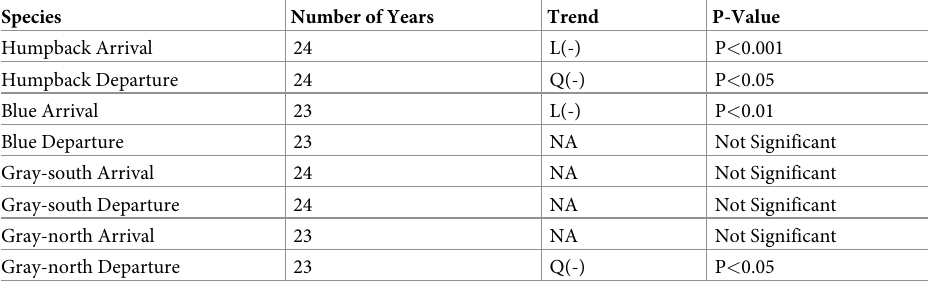
Table 2. Changes in timing for humpback, blue, and gray whale arrival and departure times. Species Number of Years Trend P-Value Humpback Arrival 24 L(-) P < 0.001 Humpback Departure 24 Q(-) P < 0.05 Blue Arrival 23 L(-) P < 0.01 Blue Departure 23 NA Not Significant Gray-south Arrival 24 NA Not Significant Gray-south Departure 24 NA Not Significant Gray-north Arrival 23 NA Not Significant Gray-north Departure 23 Q(-) P <